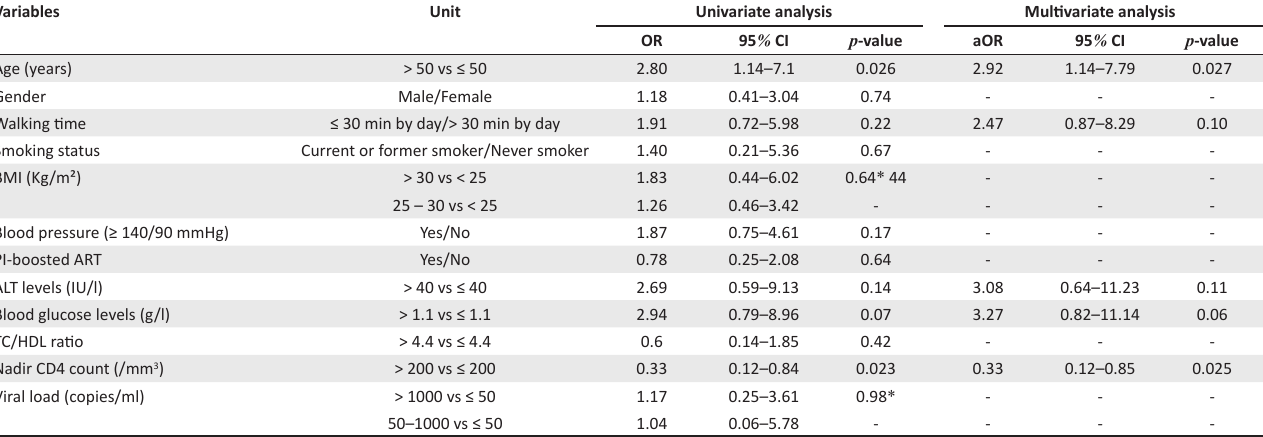
TABLE 2: Results of univariate and multivariate analysis between baseline characteristics and severe cardiovascular abnormalities, Abidjan, April 2015 – September 2015 ( N = 278). Variables Unit Univariate analysis Multivariate